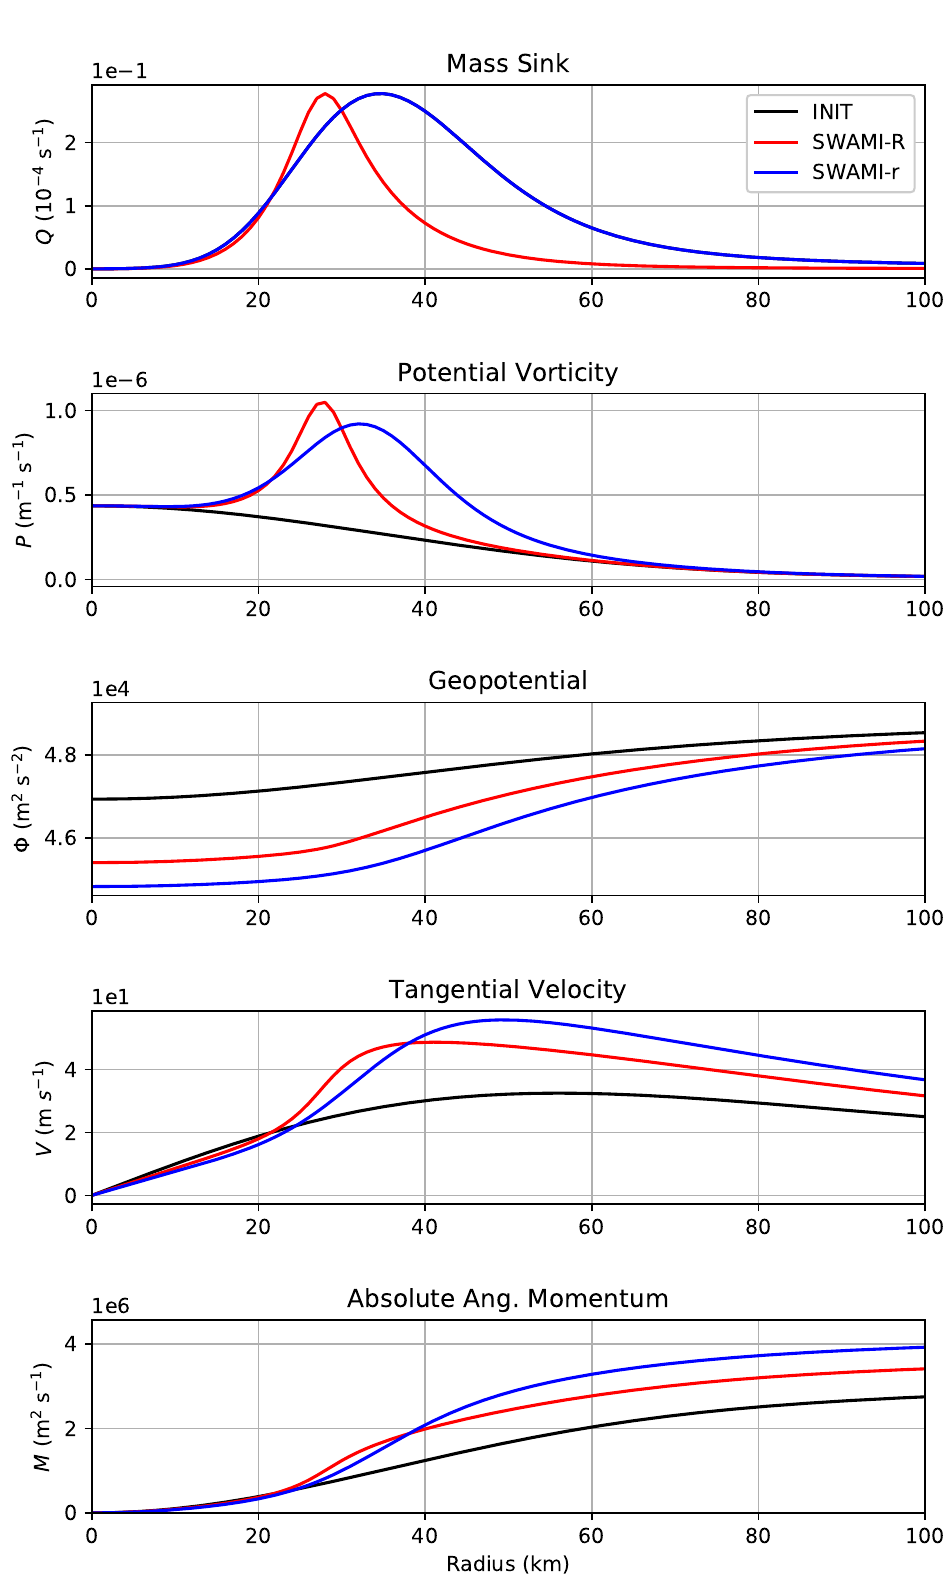
Figure 2. Same as Figure 1 but with ˙ θ = 3 K h − 1